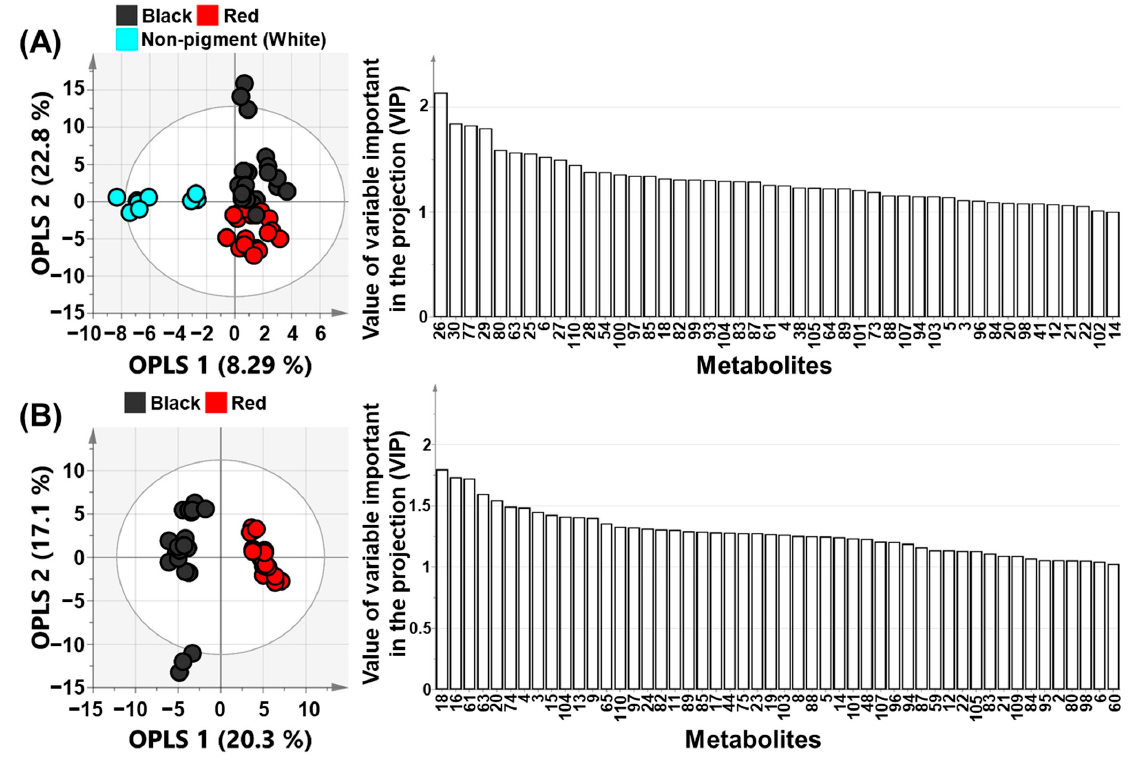
Figure 2. Orthogonal partial least squares-discriminant analysis (OPLS-DA) score and variable importance in the projection (VIP) plots derived from 110 metabolites of black, red, and non-pigmented (white) rice cultivars ( A , B ). A is comparison of non-pigmented rice and pigmented rice. B is comparison of black and red pigmented rice. The ellipse represents the Hotelling T2 with 95% confidence in the score plot. Plot annotation 1, C20-ol (Eicosanol); 2, C21-ol (Heneicosanol); 3,